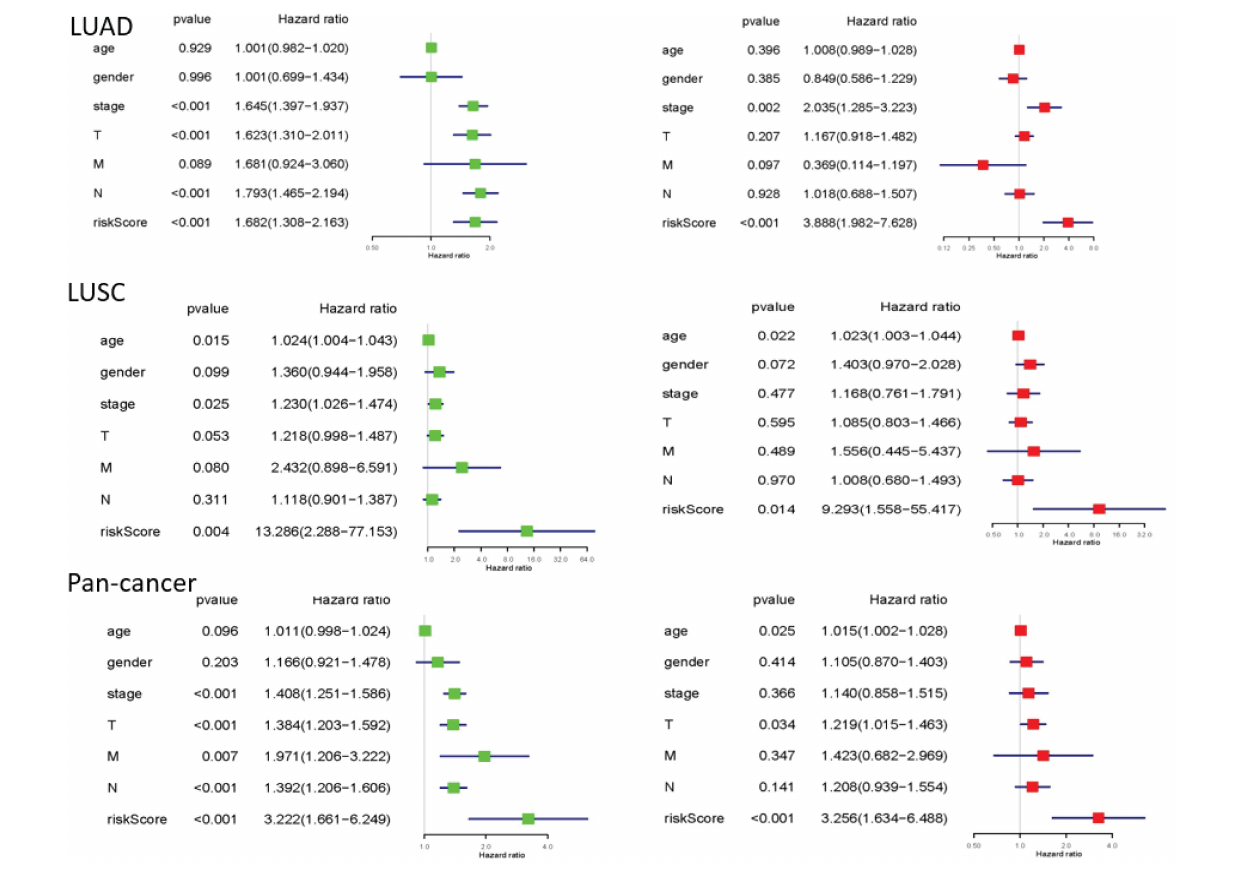
FIGURE 6 | The results of univariate and multivariate Cox regression analysis. Univariate and multivariate Cox regression analysis between overall survival rate and clinical pathological characteristics was performed for each type of lung cancer. They could identify the independent prognostic factors. When P < 0.05, the result is